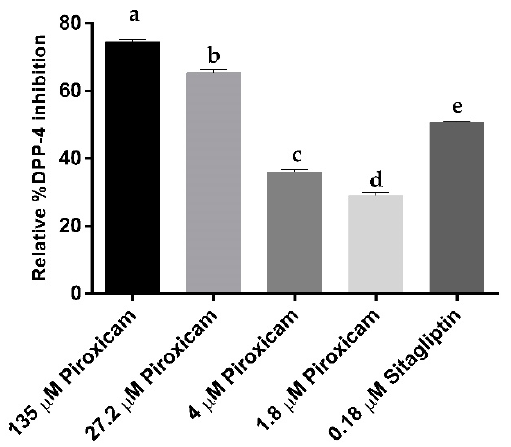
Figure 6. Comparison of relative percentages of DPP-4 inhibition by piroxicam at concentrations of 135 µ M, 27.2 µ M, 4 µ M, and 1.8 µ M, and by sitagliptin at a concentration of 0.018 µ M, respectively. Means with different letters are significantly different at p < 0.05 determined by two-tailed unpaired t -test.